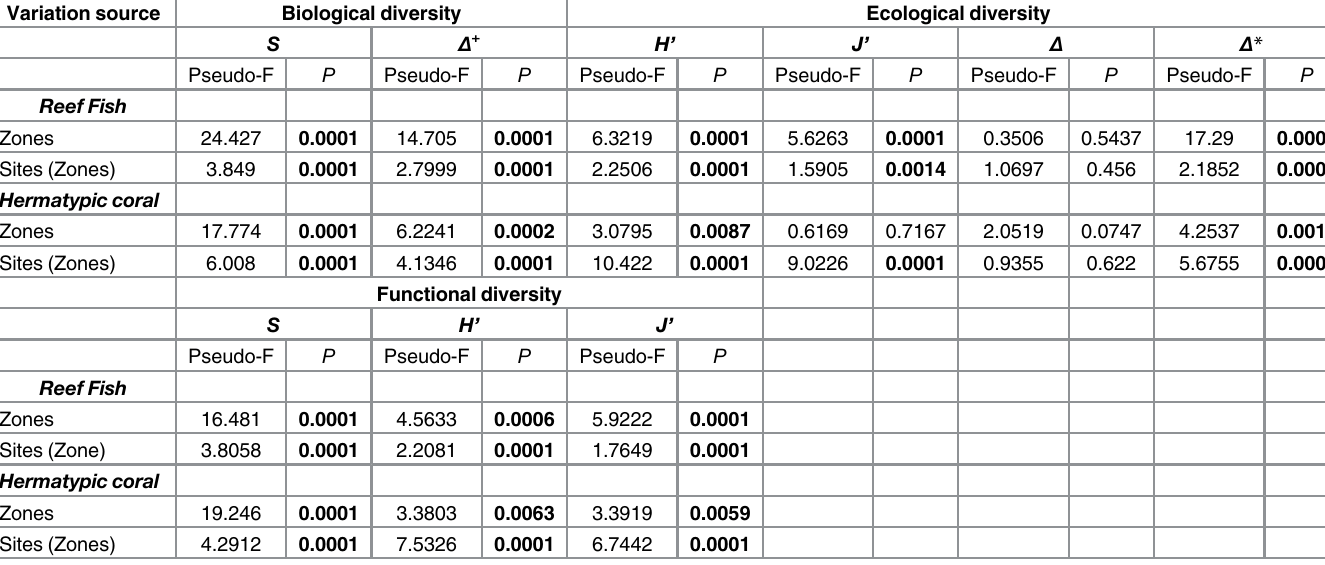
Table 1. Two-way nested permutational ANOVAs (Model 1) outcomes contrasting the biological, ecological and functional diversity of fish and hermatypic corals among zones and sites nested in zones. Variation